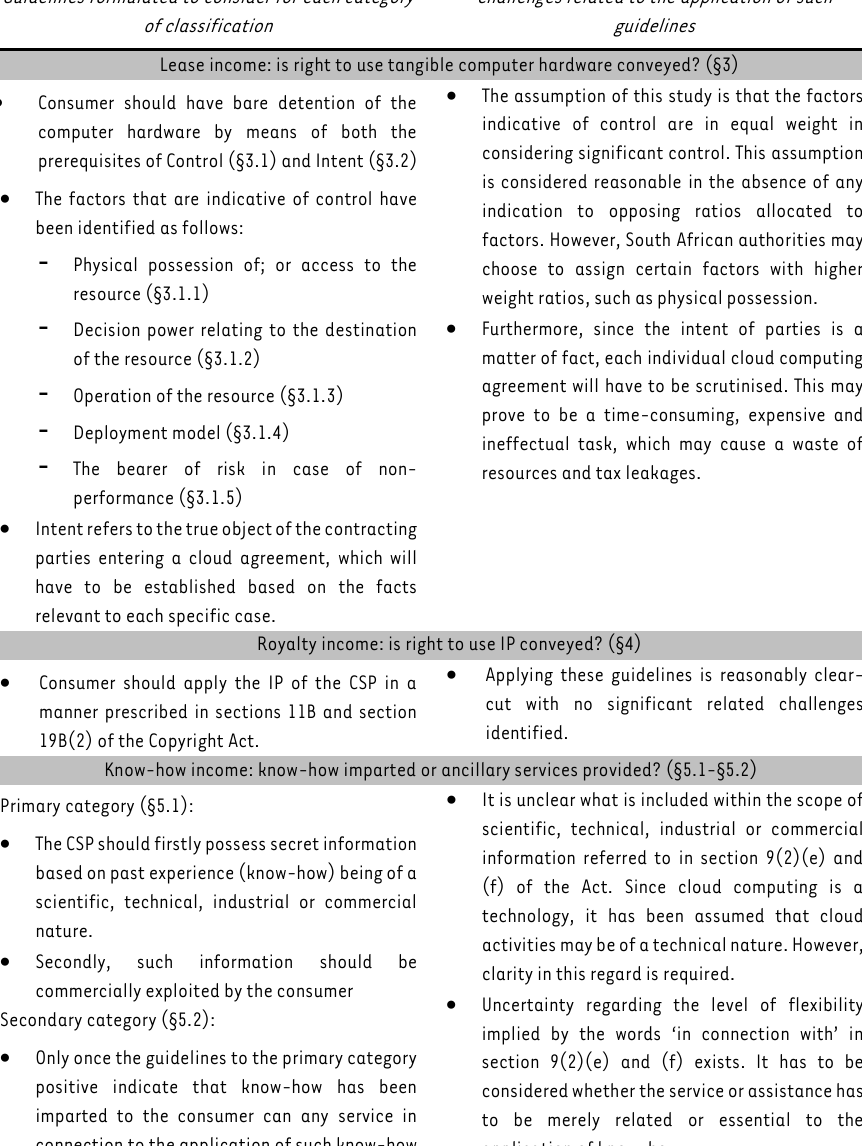
Challenges related to the application of